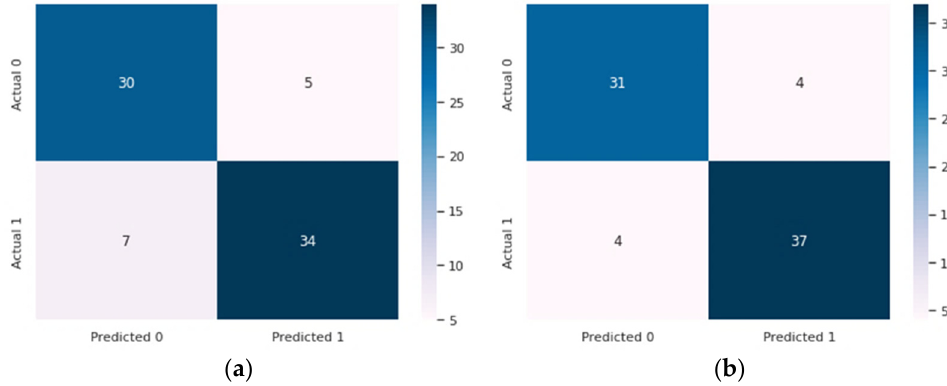
Figure 9. Confusion matrix of Cleveland dataset. ( a ) Total features; ( b ) Selected features.